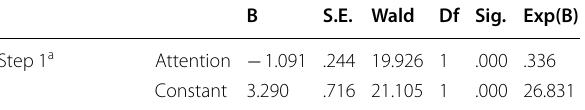
Table X: Variables in the equation for attention to details culture